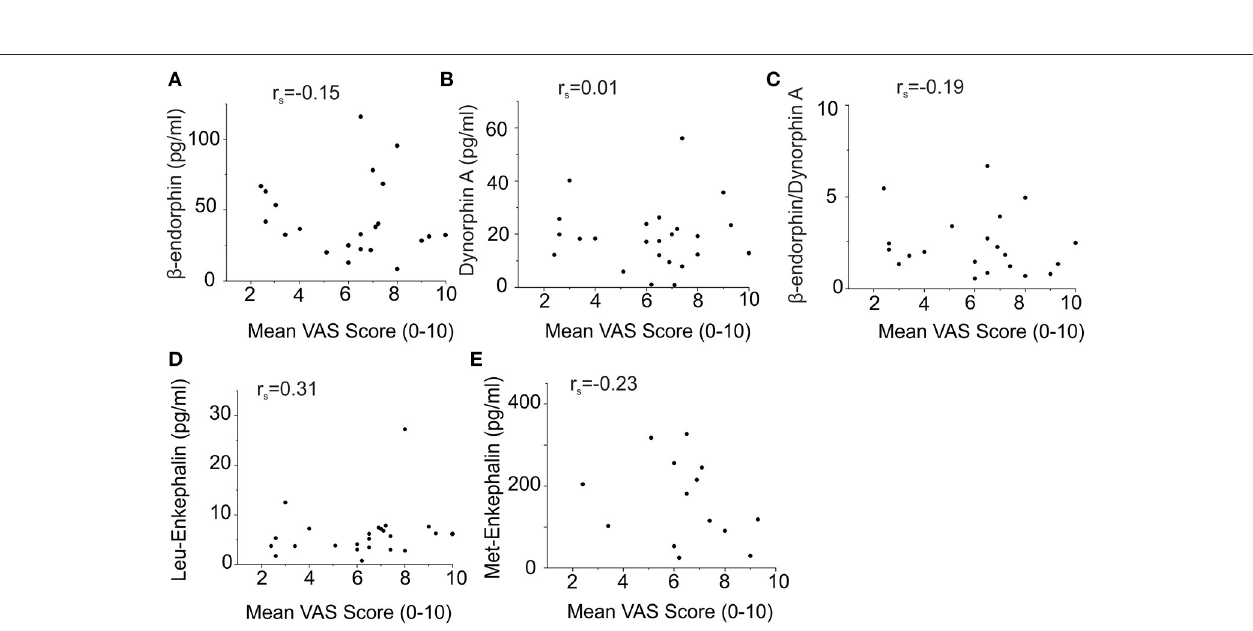
FIGURE 4 | No correlation of endogenous opioid plasma levels with mean pruritus VAS scores of patients with hepatic pruritus. Symbols (circles) represent the opioid concentration and VAS score of the individual patients, respectively. Correlations were statistically calculated using Spearman’s rank. Endogenous opioid levels did not correlate with the reported itch intensity assessed as the mean itch VAS score over the last week [ (A) β -endorphin: r s = − 0.15; (B) dynorphin A: r s = 0.01; (C) β -endorphin/dynorphin A ratio: r s = − 0.19; (D) Leu-enkephalin: r s = 0.31; (E) Met-enkephalin: r s = − 0.23].